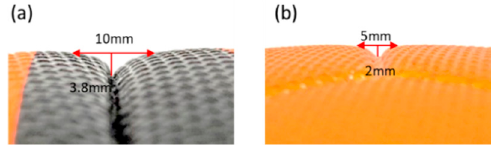
Figure 2. Soccer balls used in this experiment: ( a ) old-type soccer ball (T1), ( b ) shape of the groove